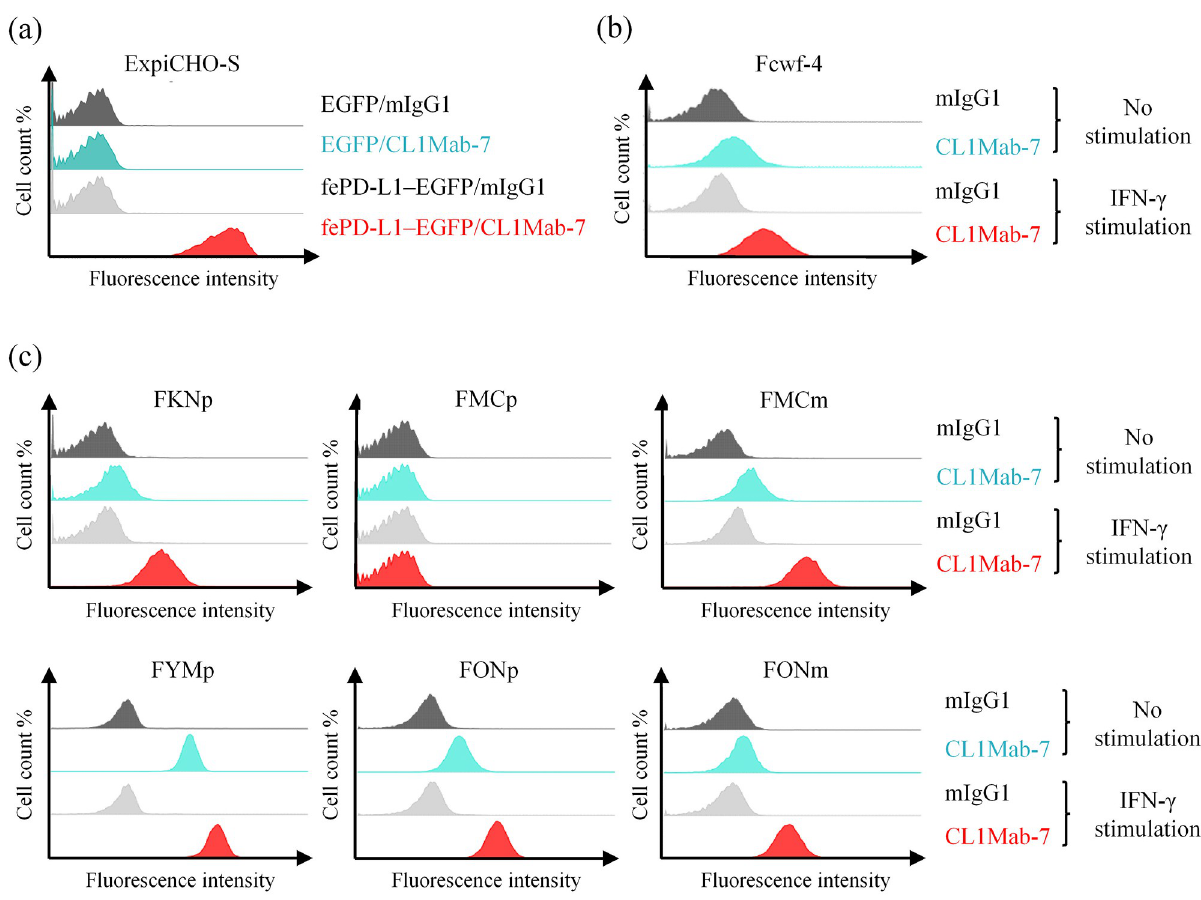
Fig 4. PD-L1 expression in feline macrophage and mammary adenocarcinoma cell lines. (a) Binding of the anti-feline PD-L1 monoclonal antibody CL1Mab-7 to fePD-L1–EGFP-expressing cells. Cells were transfected with EGFP (mock) or fePD-L1–EGFP expression vector and analyzed by flow cytometry at 24 h post transfection. (b) PD-L1 expression in the feline macrophage cell line Fcwf-4. (c) PD-L1 expression in feline mammary adenocarcinoma cell lines FKNp, FMCp, FMCm, FYMp, FONp, and FONm. Cells were incubated with 100 ng/mL of recombinant feline IFN- γ for 24 h where indicated. Mouse IgG 1 (mIgG 1 ) was used as an isotype-matched negative control antibody.